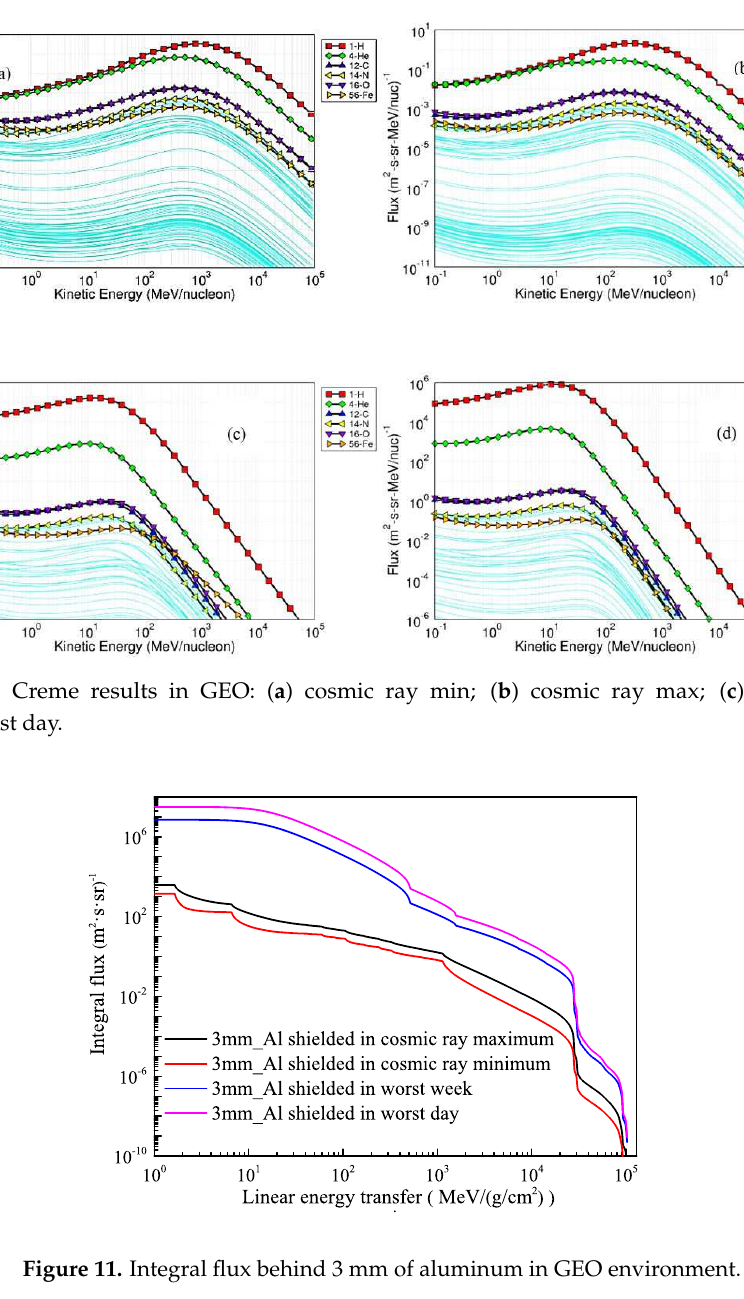
Figure 11. Integral flux behind 3 mm of aluminum in GEO